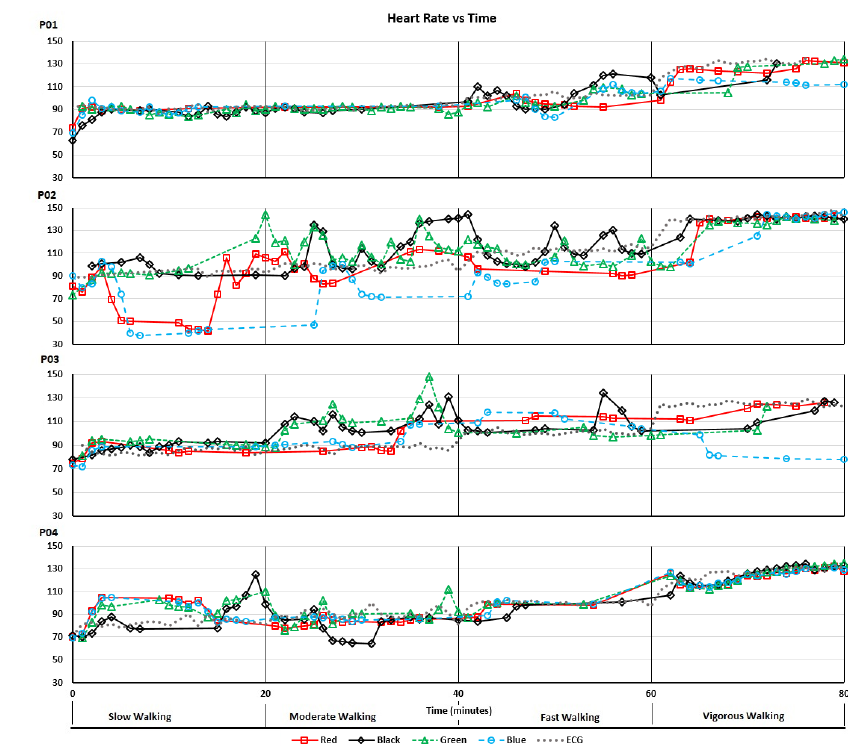
Figure 3. Heart rate recordings acquired during treadmill walking activities.